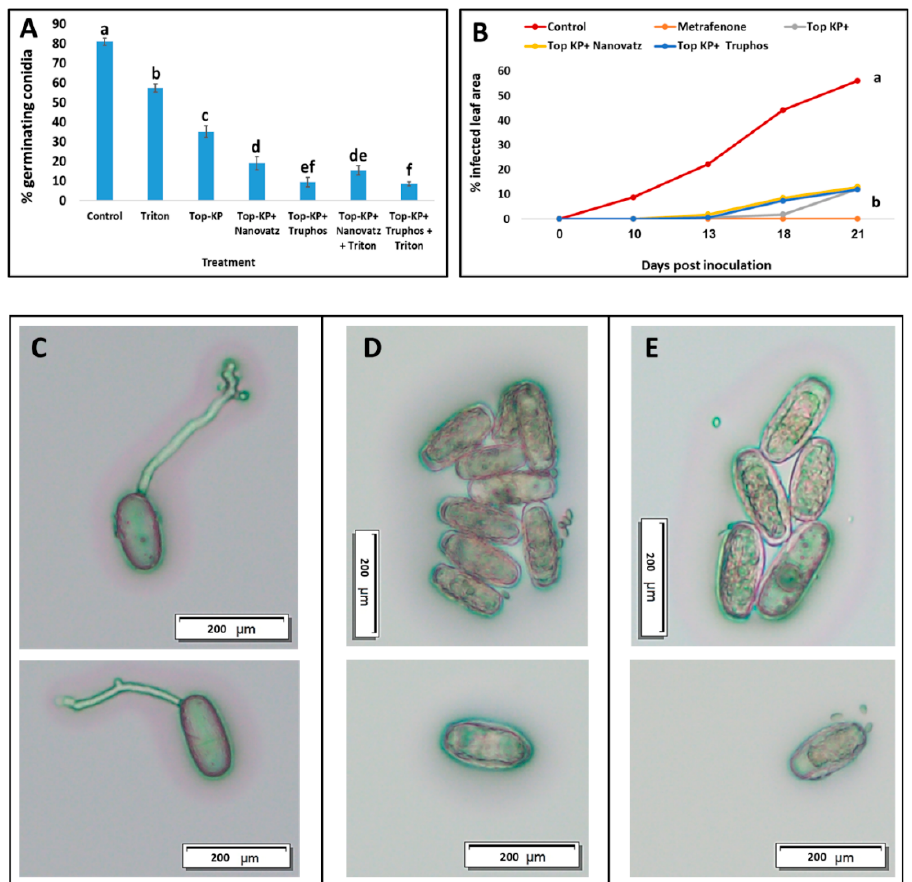
Figure 9. ( A ) The effect of Top KP+ 1% plus TruPhos 0.25% or Nanovatz 0.1% on conidial germination of E. necator in vitro. Bars represent the standard error of the mean. ( B ) Prophylactic activity of Top KP+ 1% plus TruPhos 0.25% or Nanovatz 0.1% in comparison to Vivando (metrafenone) 0.03% fungicide against grape powdery mildew on young plants. The percentage of infected leaf area on five leaves of each treated plant was recorded at various time intervals after foliar spray. Different letters indicate significant differences ( p < 0.05) according to the Fisher’s LSD K-ratio t -test. ( C ) Germinating conidia on water agar. ( D ) Inhibition of conidial germination, and disrupted conidia with shrunken intra-cellular content on water agar embedded with Top KP+ 1% plus TruPhos 0.25%. ( E ) Inhibition of conidial germination, and disrupted conidia with shrunken intra-cellular content on water agar embedded with Top KP+ 1% plus Nanovatz 0.1%. Bar = 200 µm.